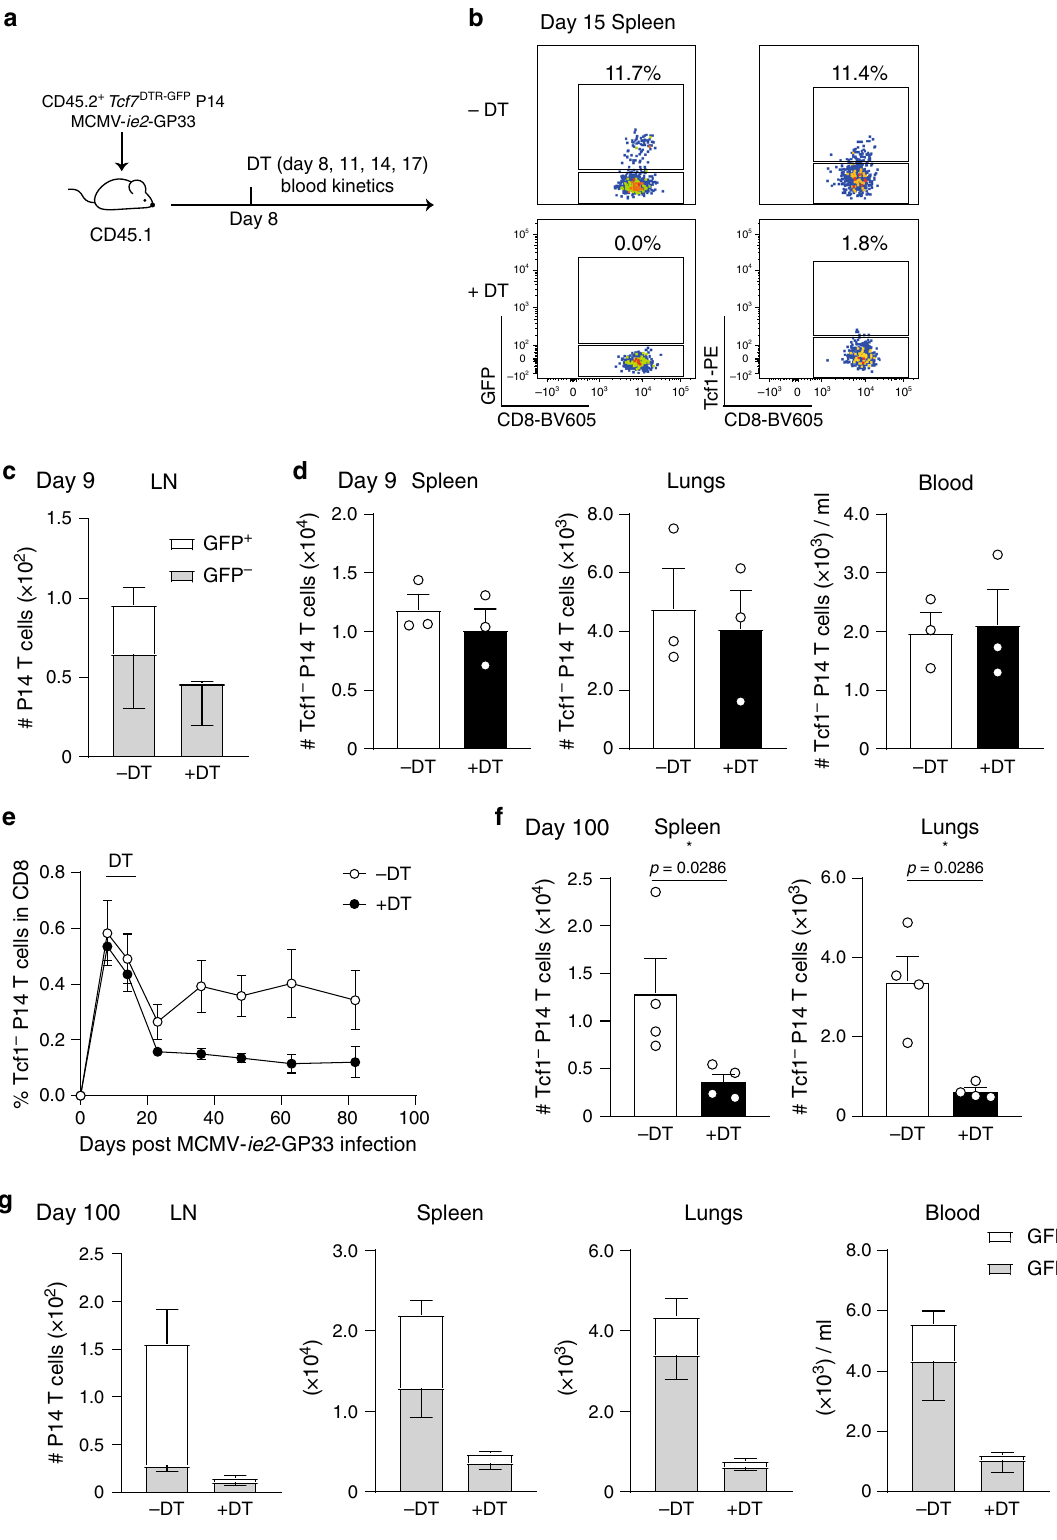
M38-speci fi c Tcf1 + and Tcf1 − sequences and in individual